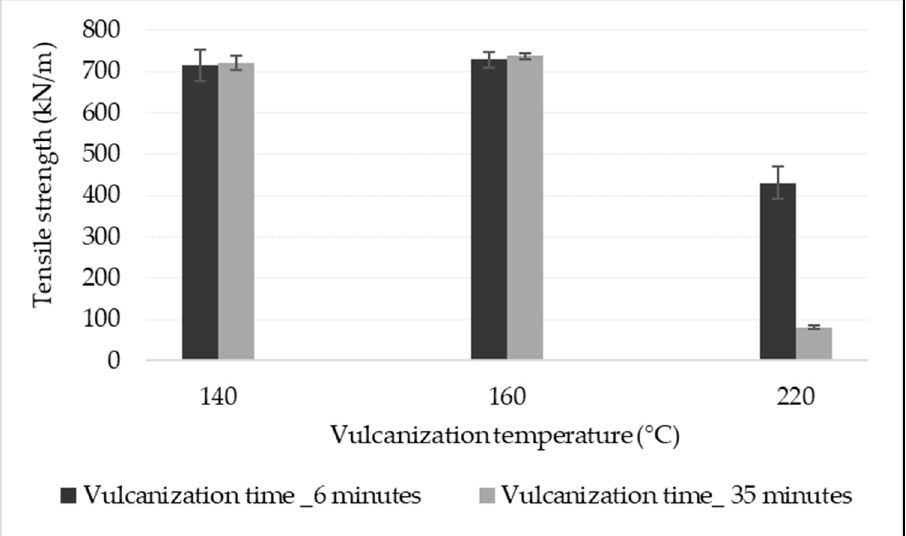
Figure 11. Effect of vulcanization conditions on the tensile strength of conveyor belt.